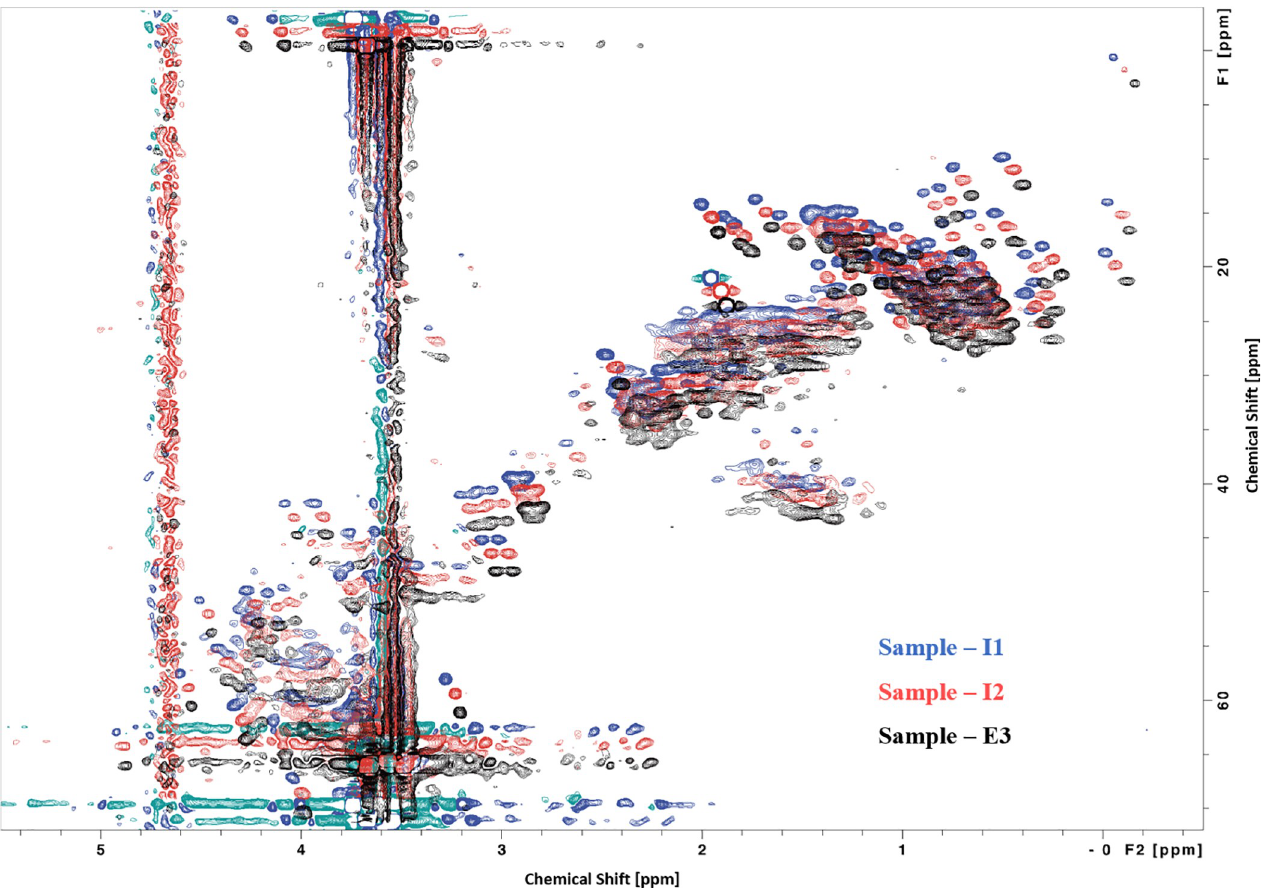
Fig 3. Shifted overlay of 1 H- 13 C HSQC spectrum for INTP5 (Sample I1, Sample I2) and EU sourced Neulasta (Sample E3).